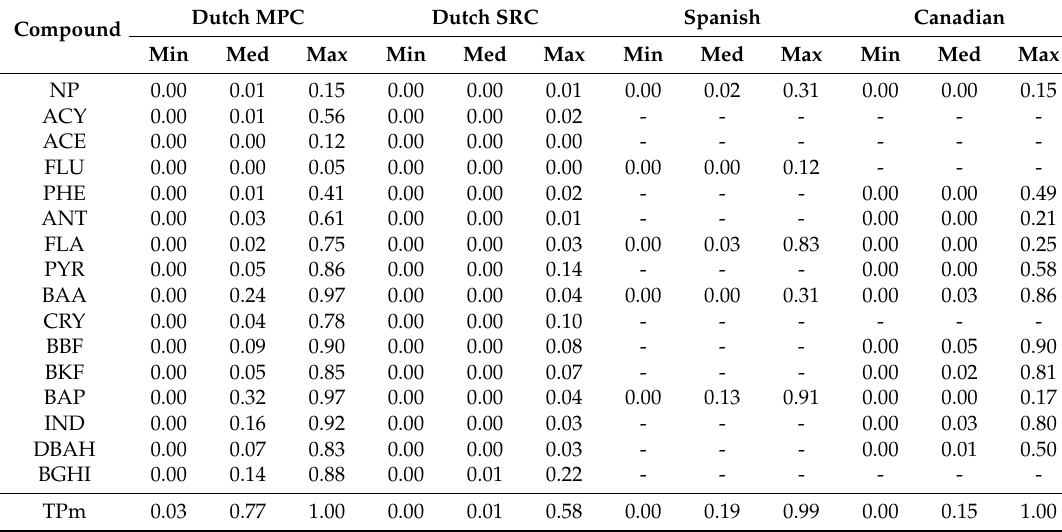
Figure 4. Contour map (interpolated by ordinary kriging) for the multisubstance potentially affected fraction (mSPAF) calculations using the concentration addition model and the maximum permissible concentration levels (HC5); the class limits correspond to the 25, 50, and 75% of potentially affected species. Table 4. Minimum, median, and maximum value of toxic pressures (TP) for individual compounds and the toxic pressures of the mixture (TPm) according to different guidelines: Dutch maximum permissible concentrations (MPC) and serious risk concentration (SRC), Spanish, and